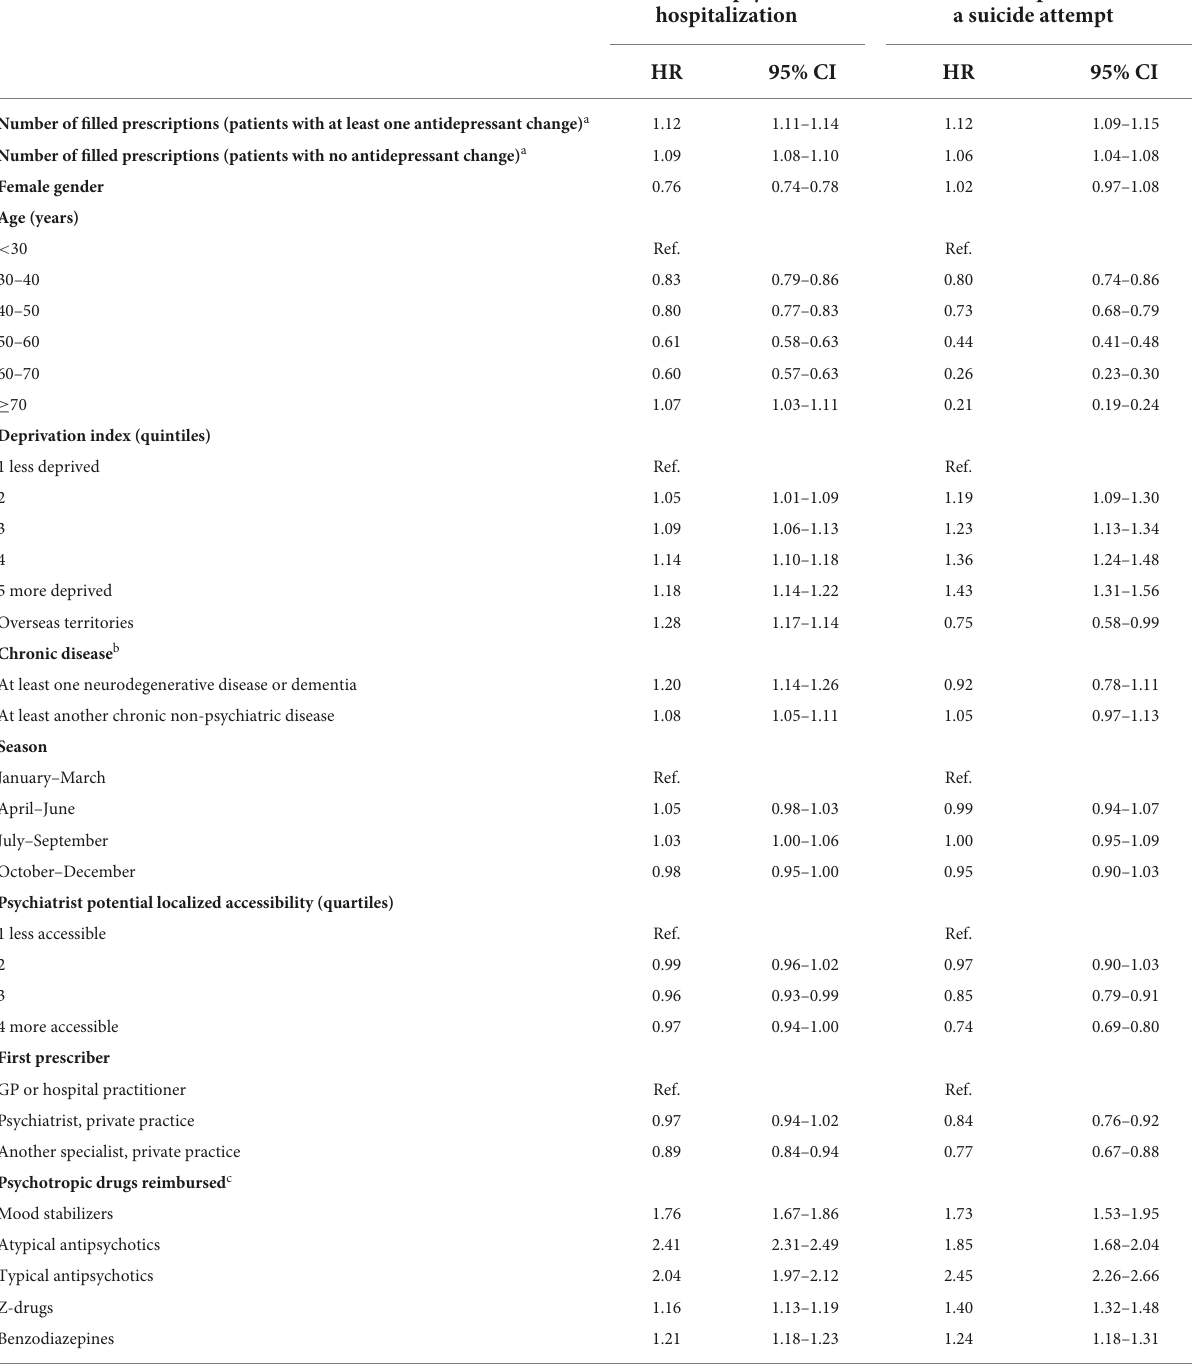
TABLE 5 Hazard ratios for the two long-term psychiatric outcomes for which there was a significant interaction between the occurrence of at least one antidepressant change and the number of filled prescriptions among patients with a least two filled prescriptions.